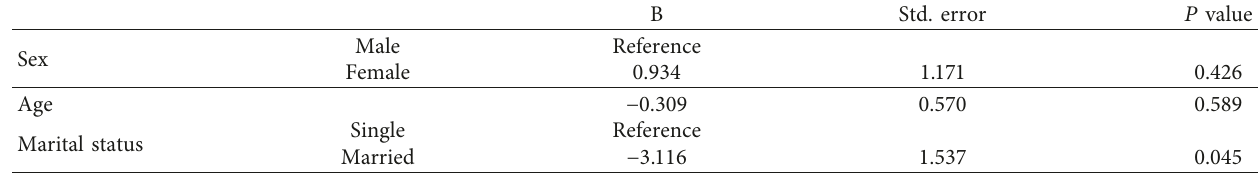
Table 5: Multivariant regression of factors affecting the total